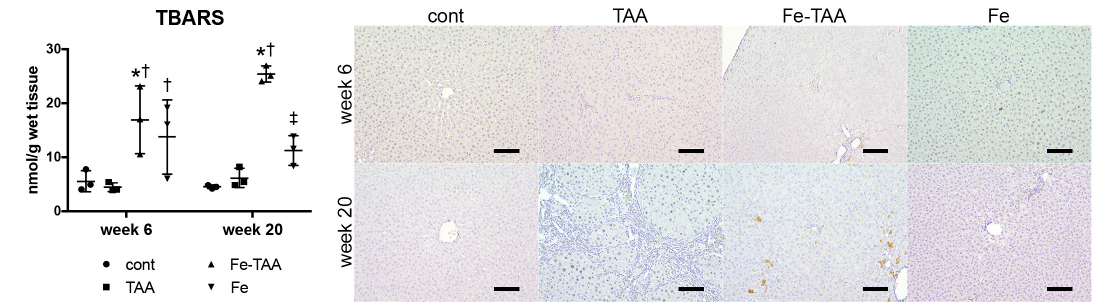
Figure 6. Hepatic thiobarbituric acid reacting substances (TBARS) levels (left) at weeks 6 and 20. Data are expressed as mean ± SD. * p < 0.05 vs. cont.; † vs. TAA; ‡ vs. Fe-TAA at the same time point, by Sidak’s multiple comparison. Immunohistochemistry for γ H2A.X (right) in the liver at weeks 6 and 20. Note hemosiderin deposits (yellow-brown pigment, apart from immunohistochemical signals) in Fe-TAA group. Bar: 100 µm.